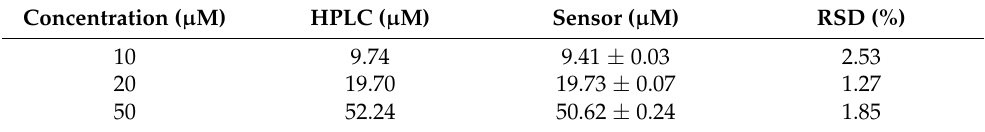
Table 2. Sample determination by HPLC and electrochemical sensor methods (n =